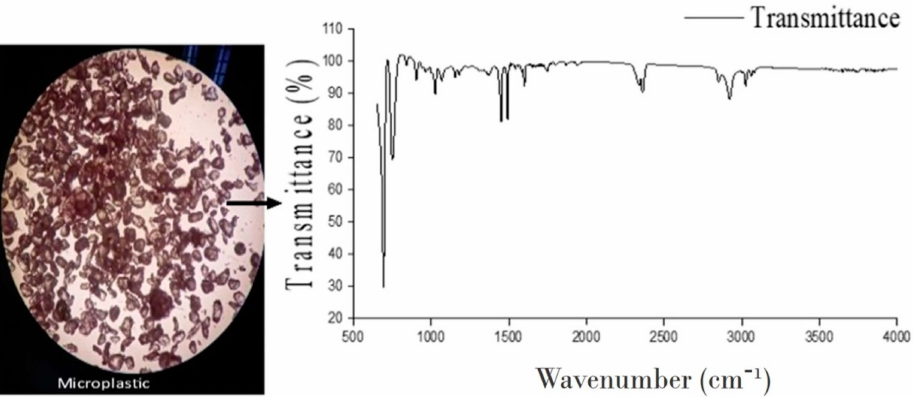
Figure 2. Photograph of MPs and the FT-IR analysis spectrum of MPs used in the experiments, corresponding with the reference spectra of polystyrene